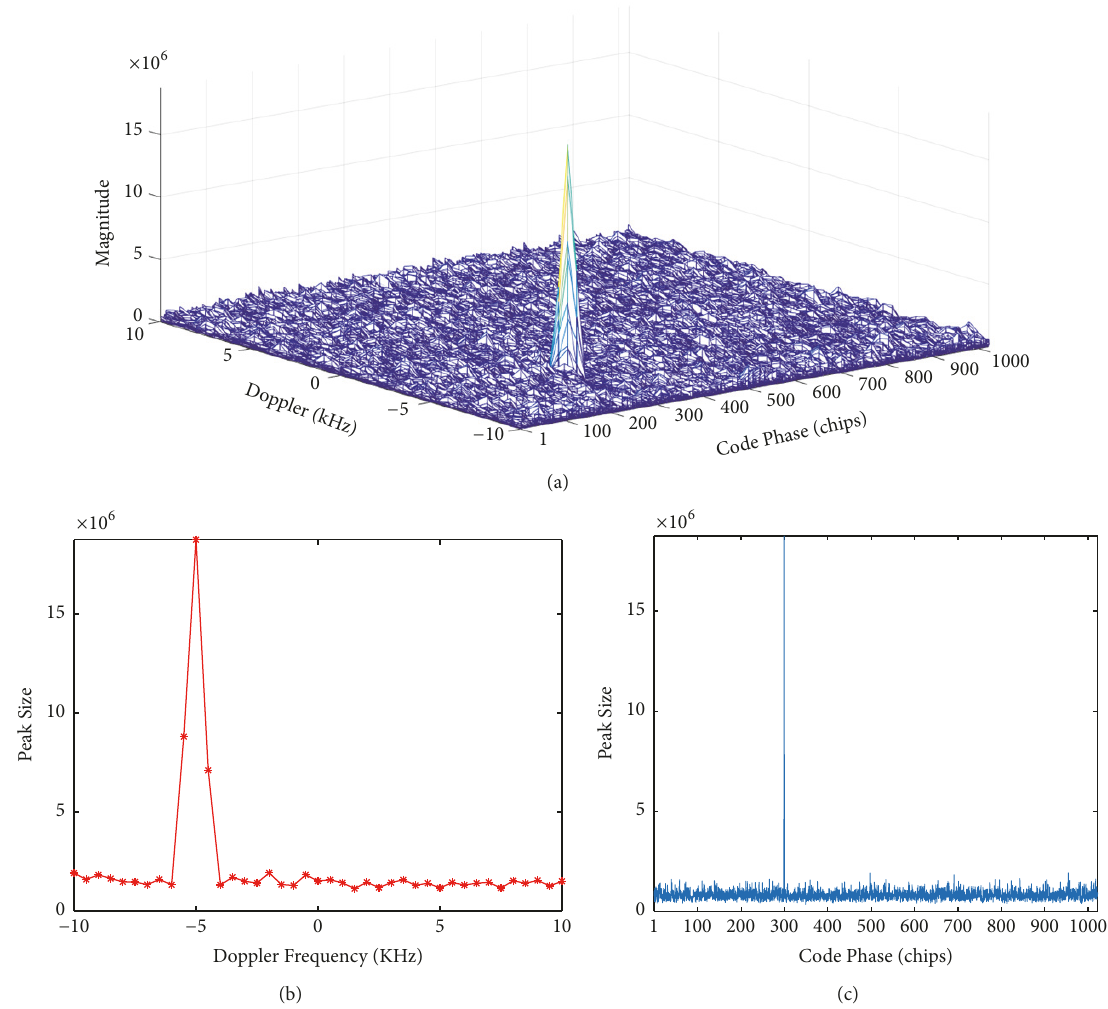
Figure 5: Acquisition results in the impulsive noises with the CSMC beamformer in GNSS receiver: (a) three-dimension domain; (b) the code phase; (c) the Doppler